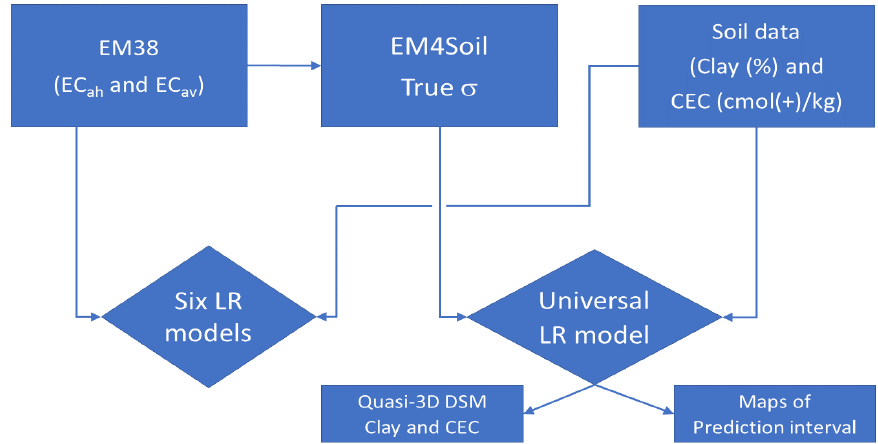
Figure 2. Flow chart of two di ff erent approaches to establish a linear regression (LR), between (i) EM38 EC a (mS / m) in horizontal (EC ah ) or vertical (EC av ) and three di ff erent depths of clay (%) or CEC (cmol( + ) / kg) data (i.e., topsoil (0–0.3 m), subsurface (0.3–0.6 m) and subsoil (0.6–0.9m), and (ii) true electrical conductivity ( σ —mS / m) inverted from EM38 EC ah and EC av with clay (%) or CEC (cmol(+)/kg) using universal LR at any depth.